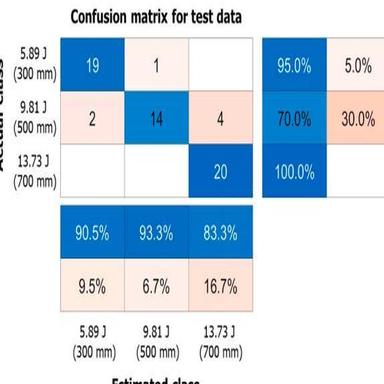
Performance evaluation results for the optimized CNN-based deep learning model for failure characterization.